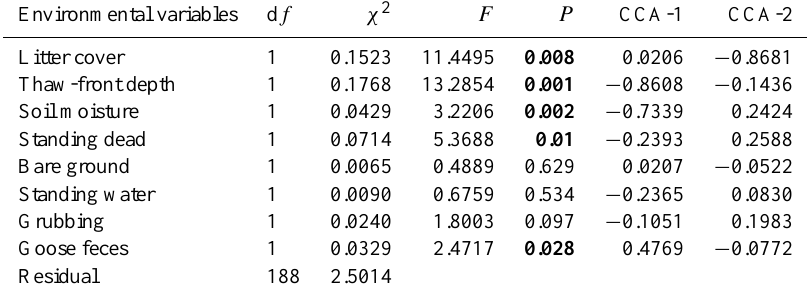
Table 4. Canonical correspondence analysis of the vegetation sampled along three gullies in the Qarlikturvik valley, Bylot Island, Nunavut, and biplot scores for environmental variables. CCA-1: first canonical axis; CCA-2: second canonical axis. Statistically significant values ( P< 0.05) after 999 permutations are shown in bold. Standing dead represents the cover of dead attached vascular plants. Environmental